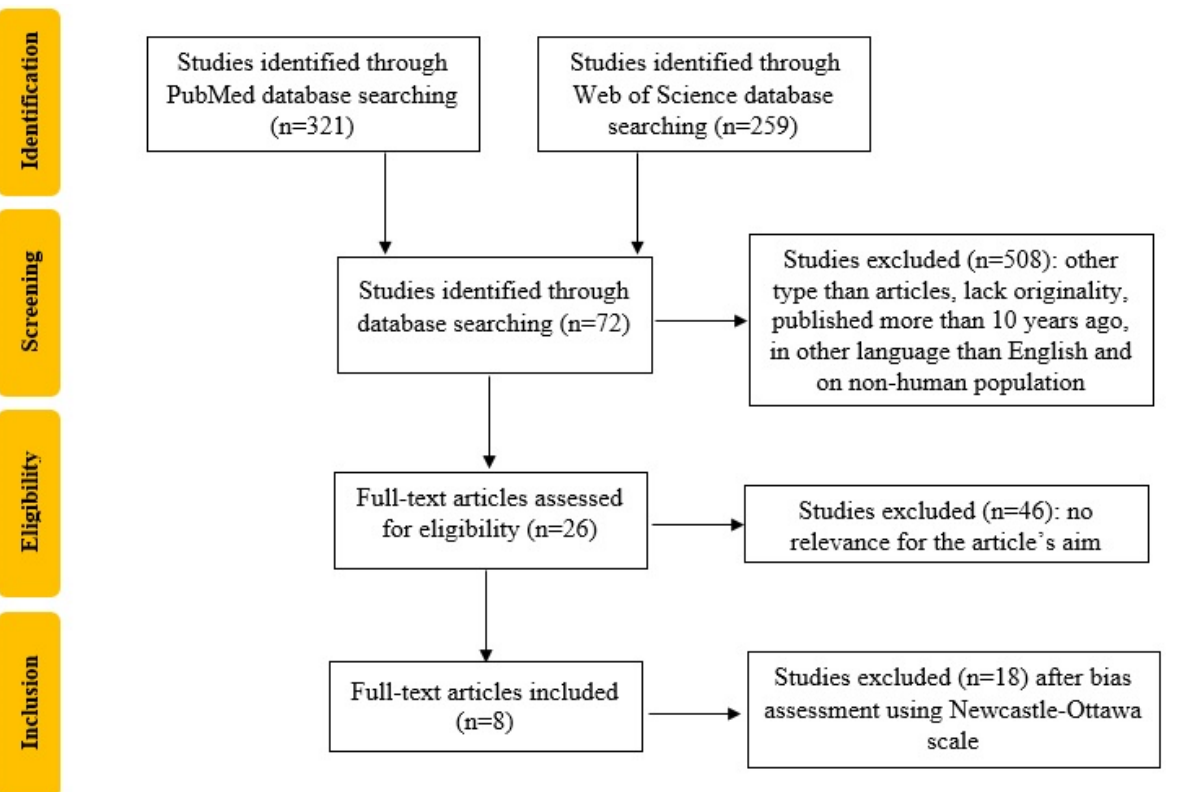
Figure 1. Study selection process flowchart according to the PRISMA guidelines.